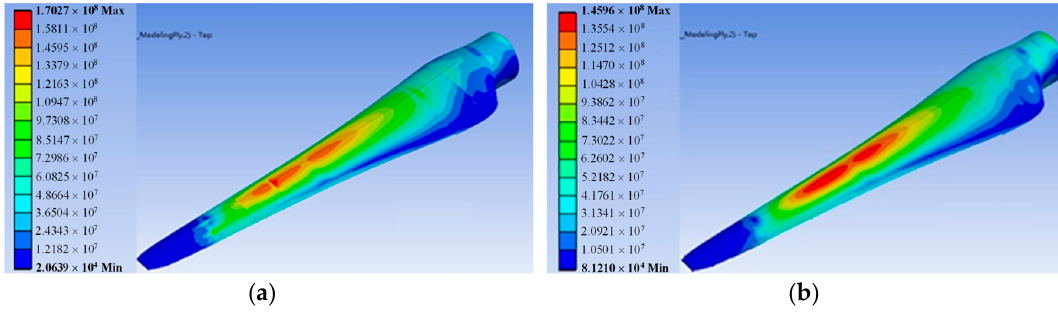
Figure 14. Comparison of stress distribution: ( a ) Original design; ( b ) Optimal design 2. Table 5. Data on the hydrodynamics and